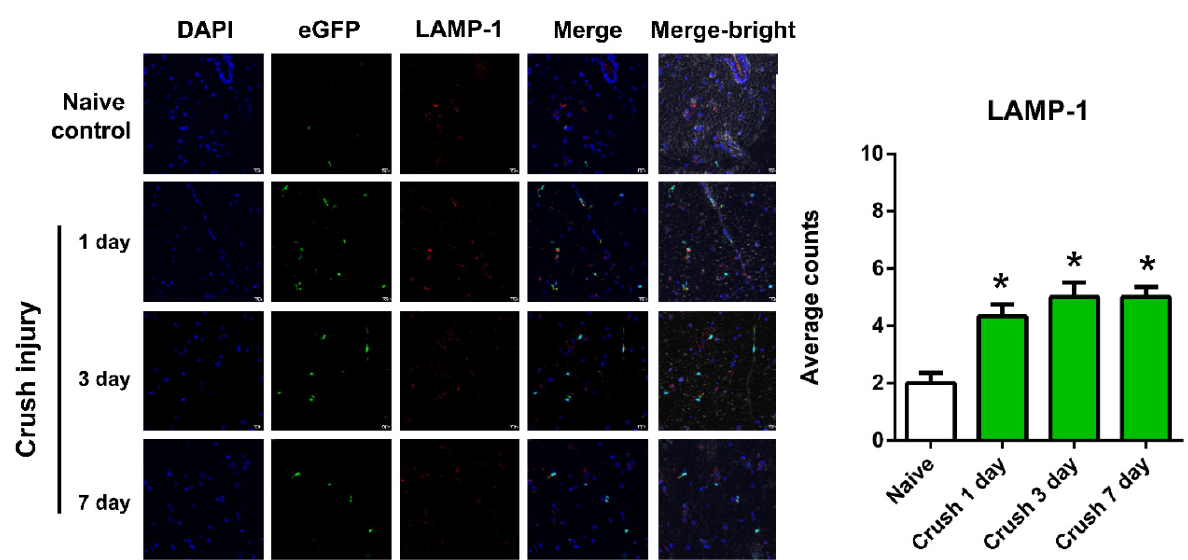
Figure 3. Immunohistochemistry of co-localization of DAPI and eGFP with the autophagy-related markers (LC3, p62, or LAMP-1) in the spinal segment of L4–6 in the MaFIA mice without nerve crush injury (naïve control) and at 1 d, 3 d, and 7 d following sciatic nerve crush injury. * Indicates a significant change ( p < 0.05) when compared to those in the naïve control ( n = 6). The error bar represents the standard error of mean.